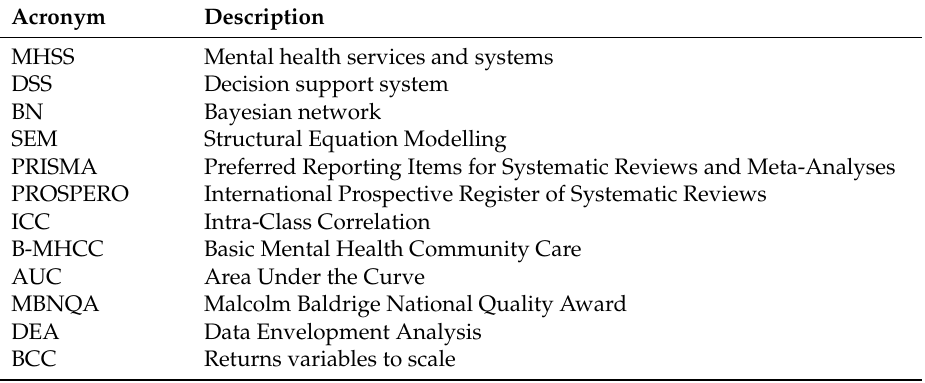
Table 1. Acronyms used in the text.